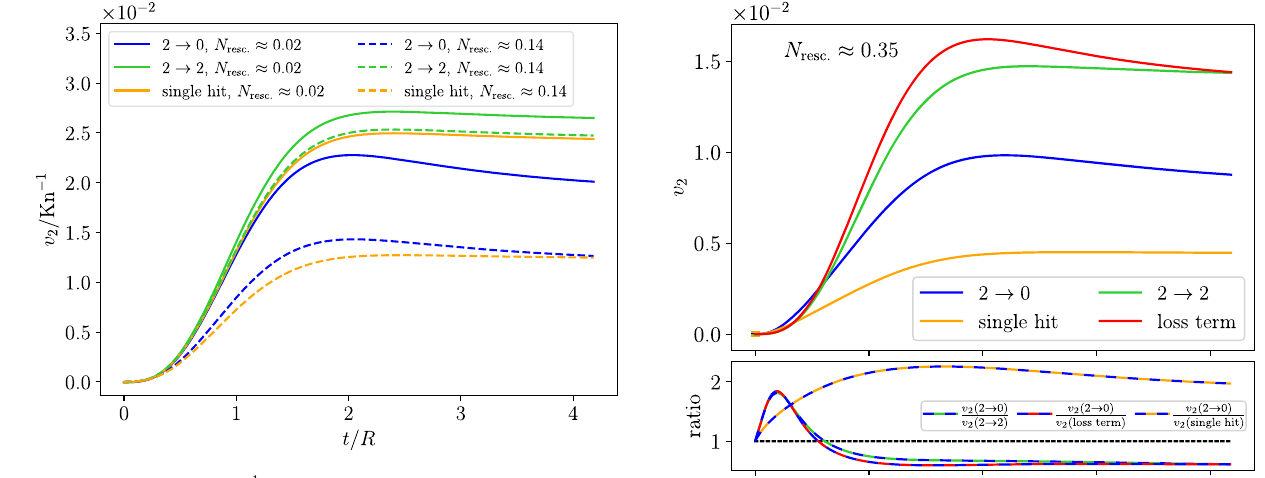
Fig. 11 Ratio v 2 ( t )/ Kn − 1 in systems with initially ε 2 = 0 . 15 and on average N resc . ≈ 0 . 02 (full lines) or 0 . 14 (dashed) rescatterings per particle for the three scenarios of the transport cascade: 2 → 2 (green), 2 → 0 (blue), single hit (orange) Fig. 12 Time dependence of elliptic flow v 2 in systems with initially